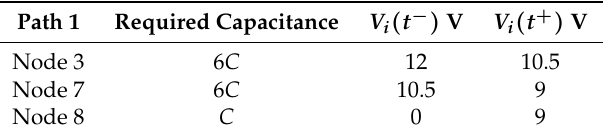
Figure 7. The arrows in this IEEE 14 test bus model of DMG show different energy flows, from the sources to the loads. Table 2. Use of equivalent voltage difference for the nodes of Path 1: 3-7-8 when the capacitance of Node 7 is sufficient.